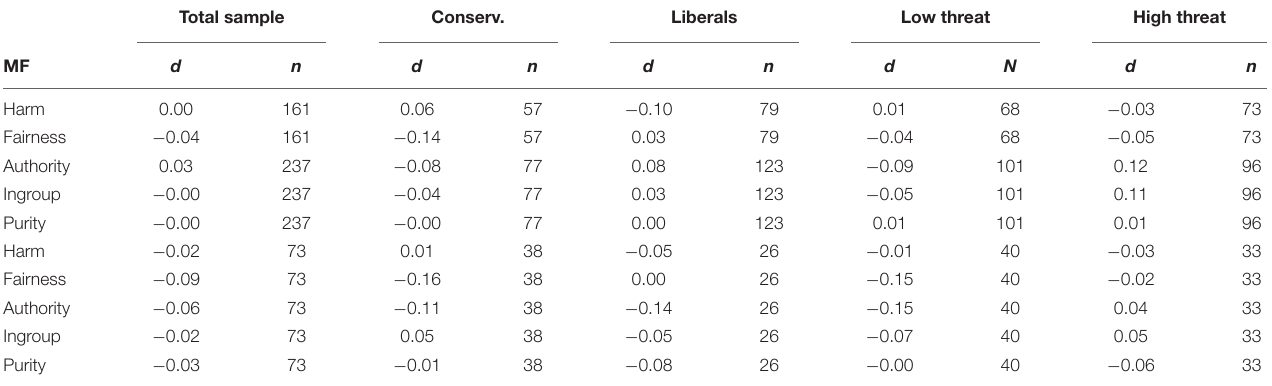
TABLE 3 | Mean increase or decrease (negative values) in standardized moral foundations scores ( d av ) in the full sample (top half) and in the subsample that completed the full MFQ (bottom half). Total sample Conserv. Liberals Low threat High